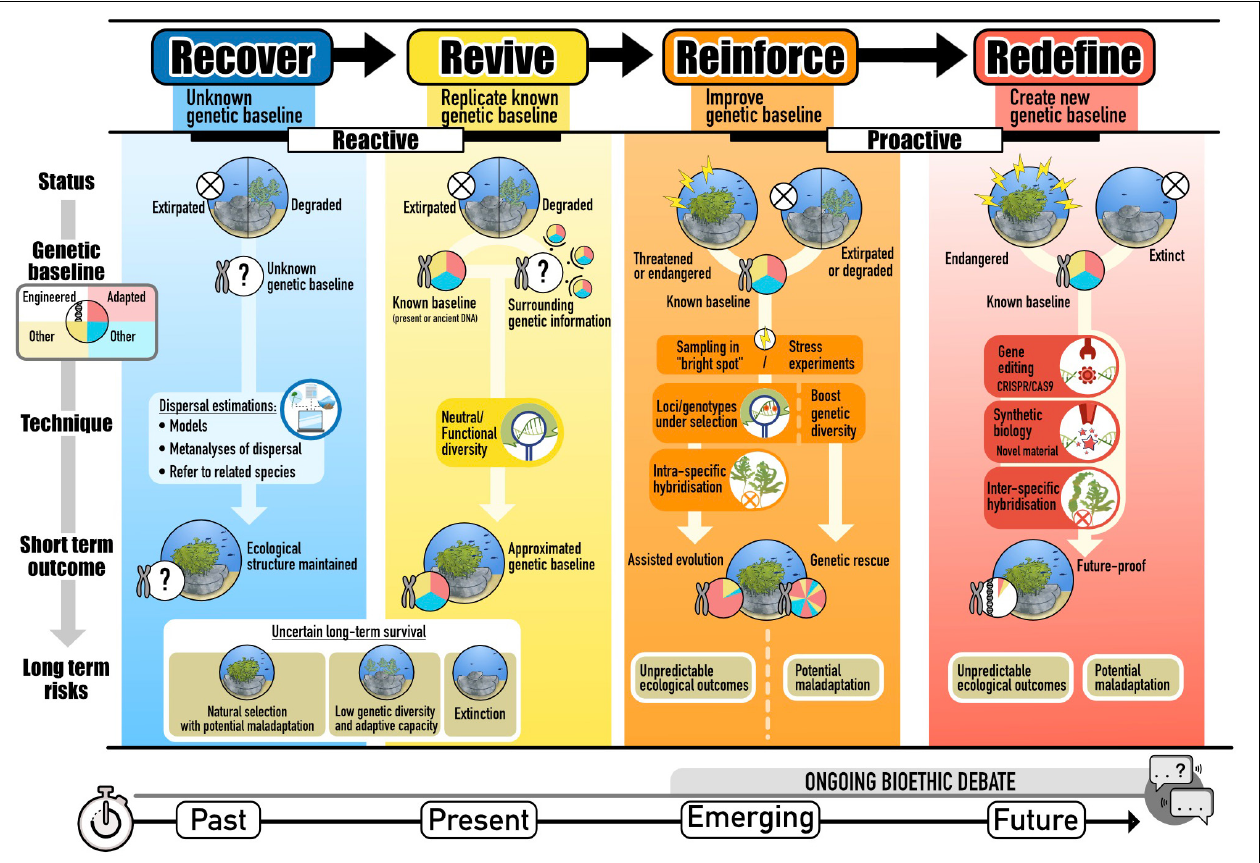
FIGURE 1 | Different motives for restoration. Whether to recover or revive historic and extant genetic baselines or reinforce and redefine to unknown baselines for future conditions, is a critical choice in restoration programs that determines possibilities for adaptability and persistence under future environmental conditions and